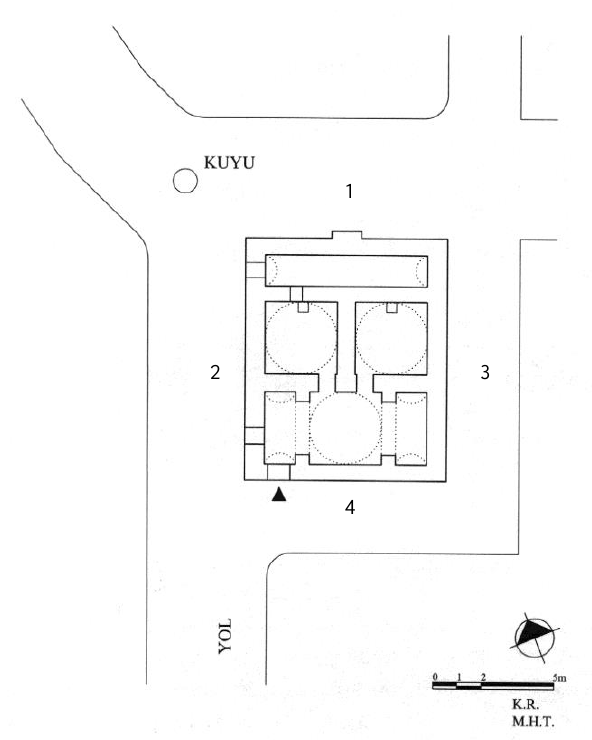
Figure 2 Plan of studied building (Hamamcioglu – Turan, Reyhan, 2005)